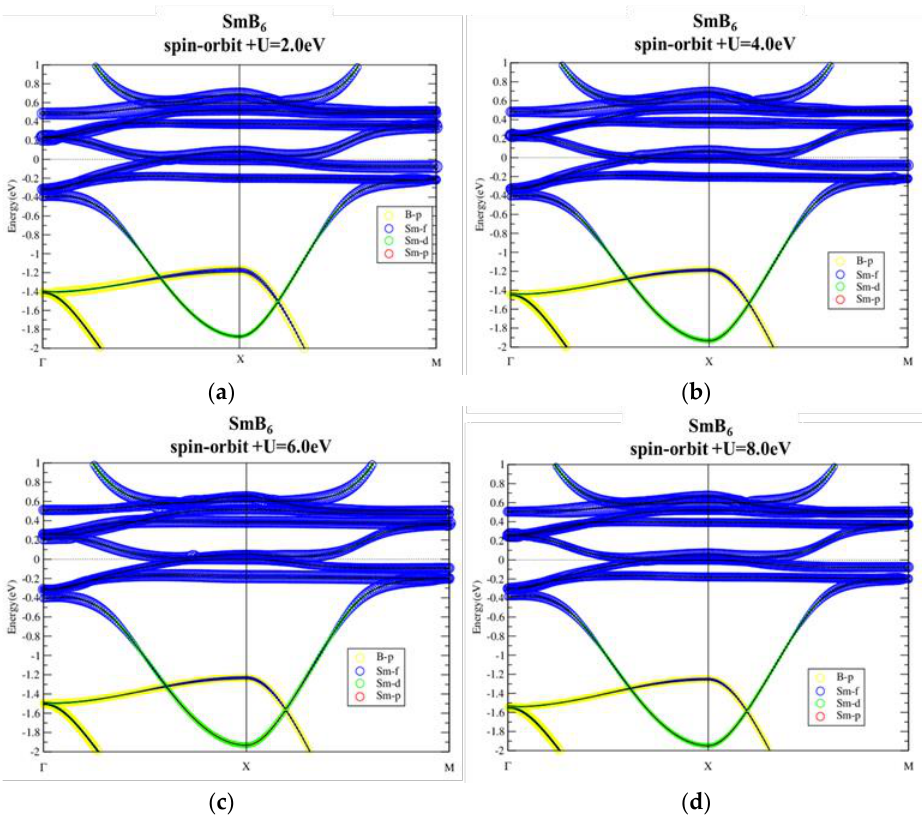
Figure 9. Band structures of SmB 6 with spin–orbit interaction using on-site U = 2.0, 4.0, 6.0, and 8.0 eV ( a–d , respectively) projected by f and d electrons of Sm.